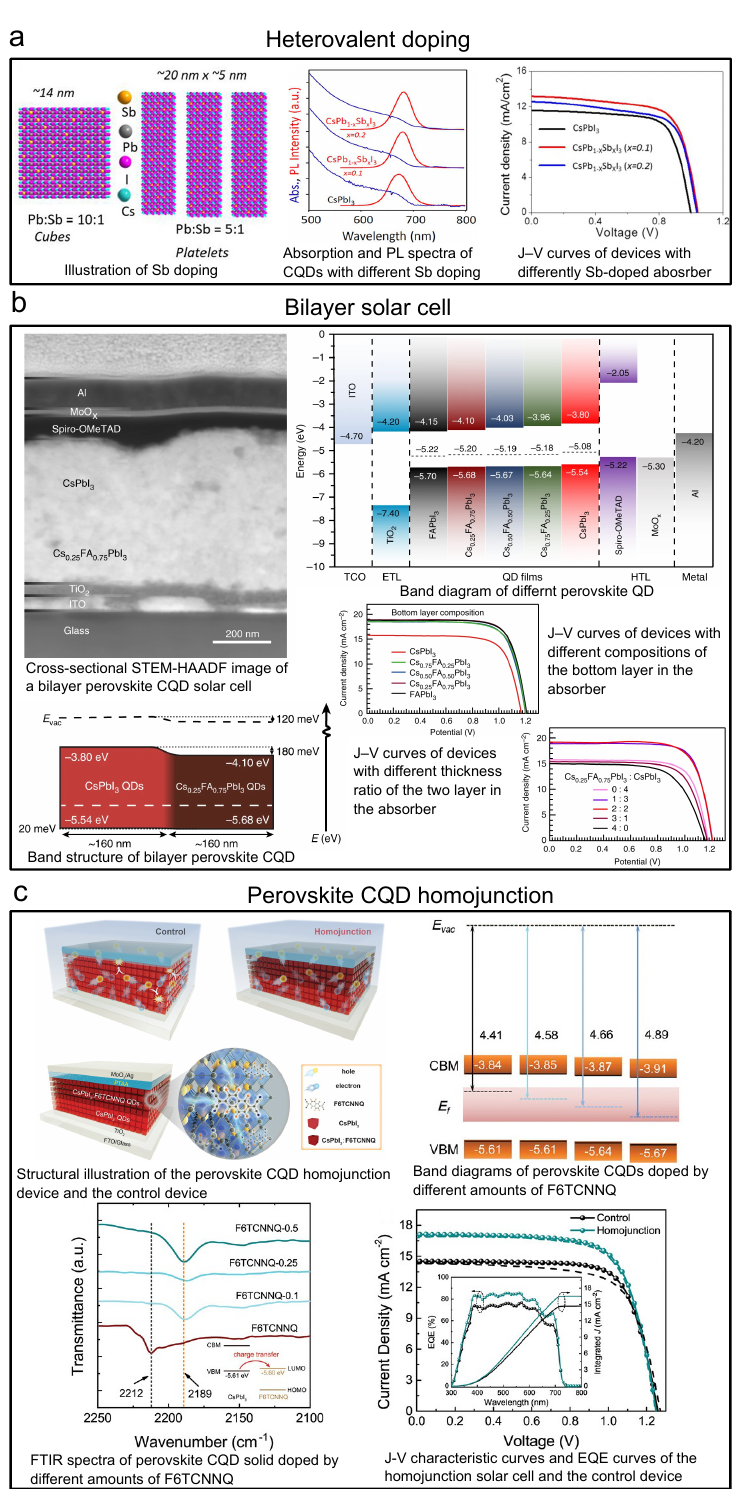
Figure 12. Key graphs of iconic perovskite CQD solar cells accomplished by heterovalent dop- ing, bilayer structure, and homojunction structure. Explanation of each sub-figure is shown be- side it. ( a ) Perovskite CQD solar cell with heterovalent doping. Reprinted with permission from [161]. Copyright 2019 American Chemical Society. ( b ) Bilayer-structured perovskite